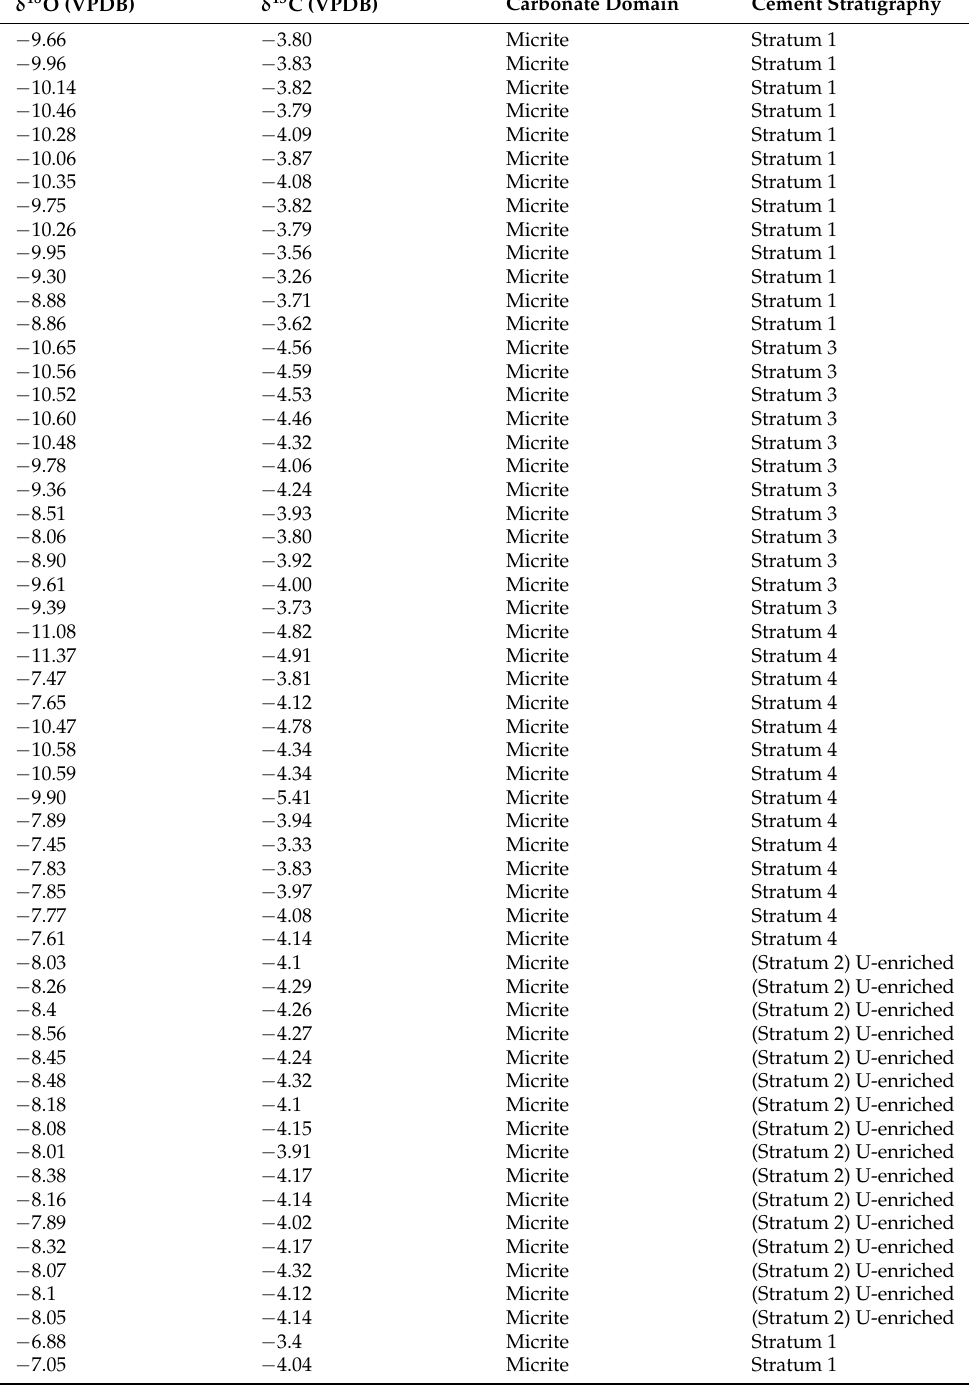
Table 3. Stable isotope results and carbonate